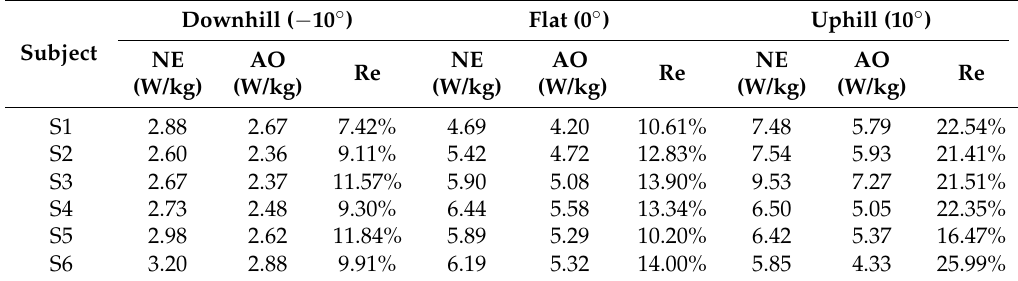
Table 3. Metabolic testing results of the downhill, flat, and uphill modes. Where NE and AO represent the no exoskeleton and the assist on modes, respectively, which means subjects were either not wearing the exoskeleton or wearing exoskeleton, Re represents the reduction.